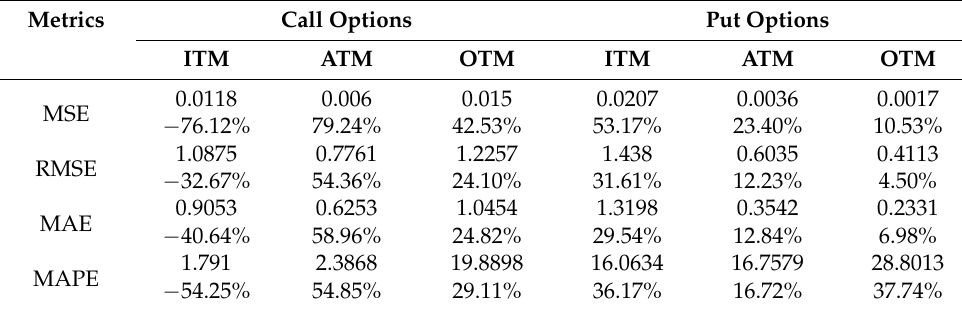
Table 6. Pricing error of LSTM with realized skewness.